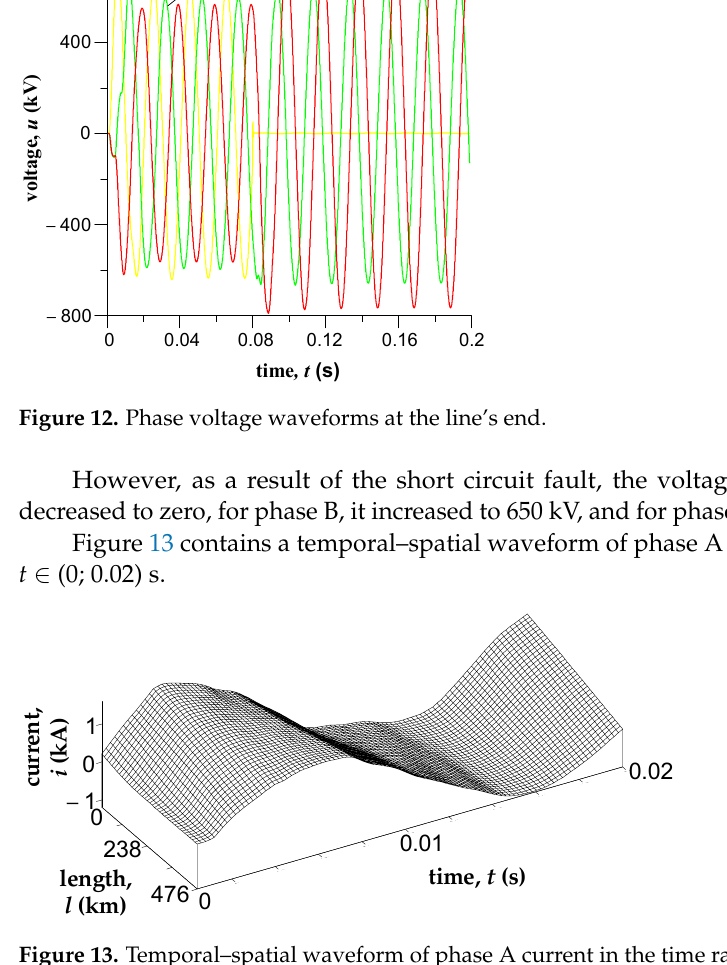
Figure 13. Temporal–spatial waveform of phase A current in the time range t ∈ (0; 0.02) s. Reasons for the shape of the current waveform can be found by analyzing the elec- tromagnetic wave’s motion. Transient processes can be analyzed on the basis of the temporal–spatial current waveform from the perspective of the electromagnetic